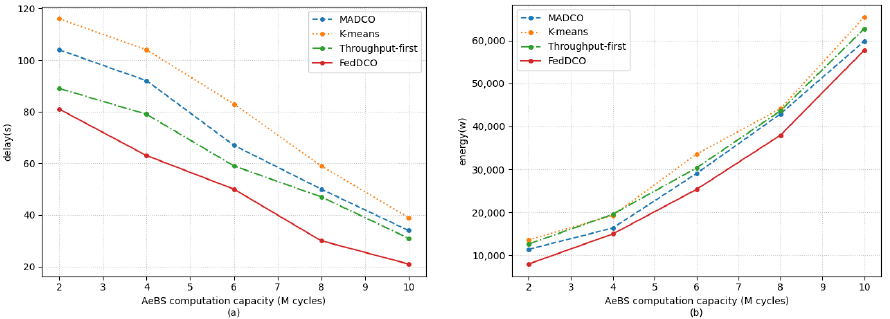
Figure 6. Comparison of network performance metrics at different computational capacities of the AeBSs. ( a ) Task processing delay. ( b ) Energy consumption.